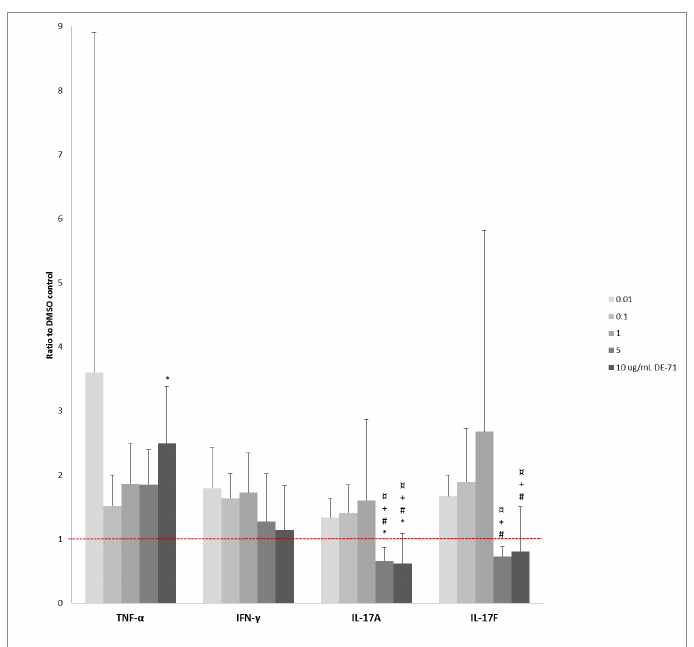
Fig 2. Influence of DE-71 on cytokine responses of PBMCs. Mean + SD of secretion of TNF- α , IFN- γ , IL- 17A, and IL-17F from DE-71 exposed and PHA-L-stimulated PBMCs are shown as ratios to the respective DMSO controls. The red dotted line indicates the level of the DMSO controls (ratio = 1). * = p < 0.05 compared to DMSO control, # = p < 0.05 compared to 0.01 μ g/mL DE-71, + = p < 0.05 compared to 0.1 μ g/mL DE-71, ¤ = p < 0.05 compared to 1 μ g/mL DE-71. PBMC: peripheral mononuclear cells, PHA-L: phytohemagglutinin-L, TNF- α : tumor necrosis factor- α , IFN- γ : interferon- γ , IL-17A: interleukin-17a, IL-17F: interleukin-17F DMSO = dimethyl sulfoxide, SD = standard deviation.